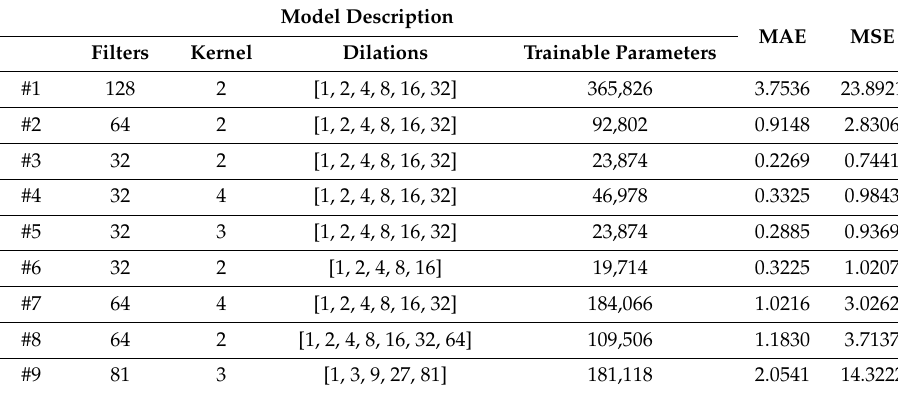
Table 5. Parameter optimization for TCN models.